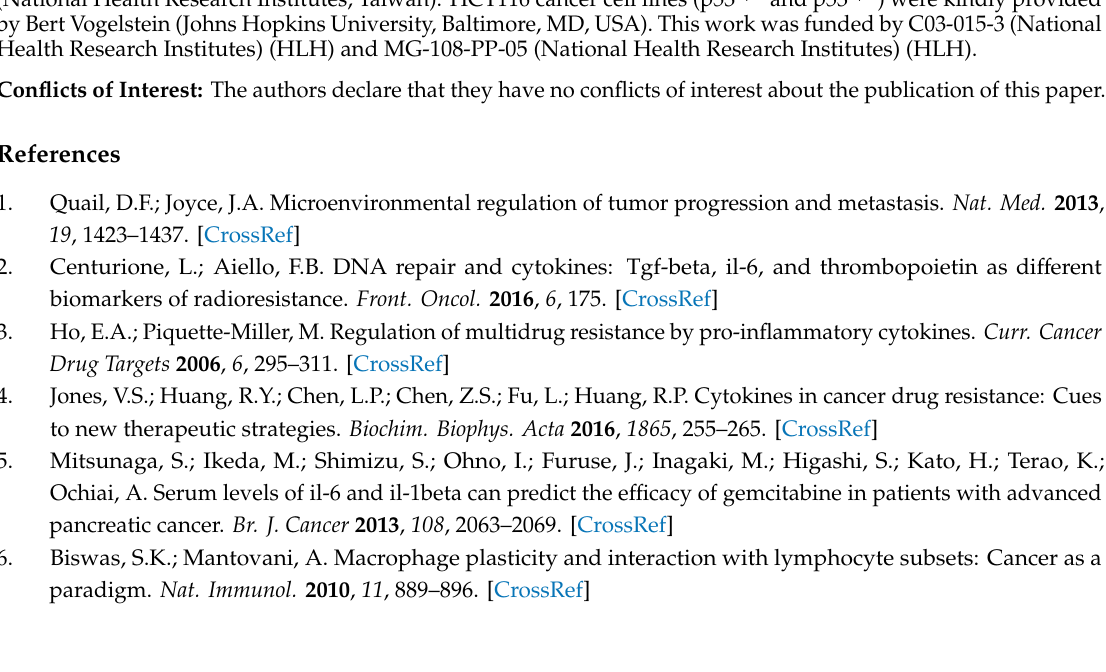
Figure S1: Macrophage polarity in response to di ff erent stimuli, Figure S2: Flow cytometry results of isotype IgG controls and MOCK treatment in monocytes, M0 macrophages and M2 macrophages, Figure S3: The e ff ects of LMF and HMF., Figure S4: DPI and / or Oligo-Fucoidan treatment regulate macrophage polarity, Figure S5: THP-1 cell viability and Raw264.7 macrophage polarity, Figure S6: Oligo-Fucoidan and cisplatin cooperatively induces p21 expression and G2 / M arrest, Figure S7: Oligo-Fucoidan and cisplatin together promote the ROS signaling axis, Figure S8: Cisplatin and / or Oligo-Fucoidan treatment of cancer cells shift monocytes to M1macrophages, Figure S9: MDA-MB231 cells treated with cisplatin and Oligo-Fucoidan induce monocytes polarization toward M1 macrophages, Figure S10: HCT116 tumors upon cisplatin and / or Oligo-Fucoidan